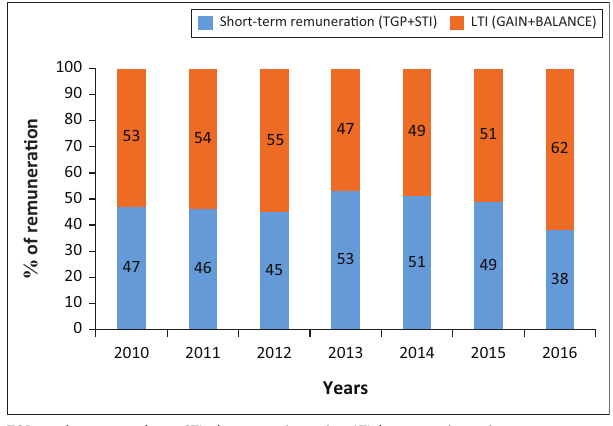
FIGURE 4: Breakdown of total Figure 4 indicates the change in the structure between short-term remuneration (TGP+STI) and long-term